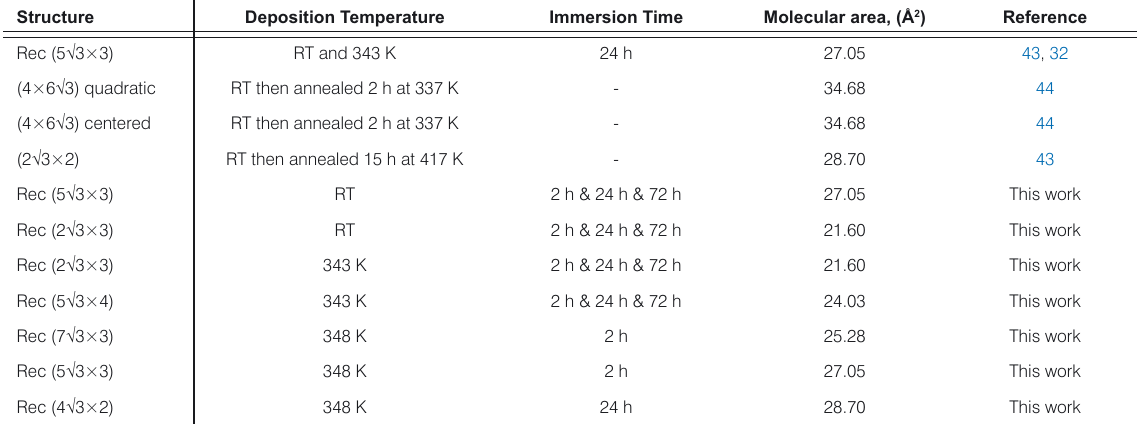
Table 1. Structures Adopted by BP2-SAMs at Different Deposition Temperatures.